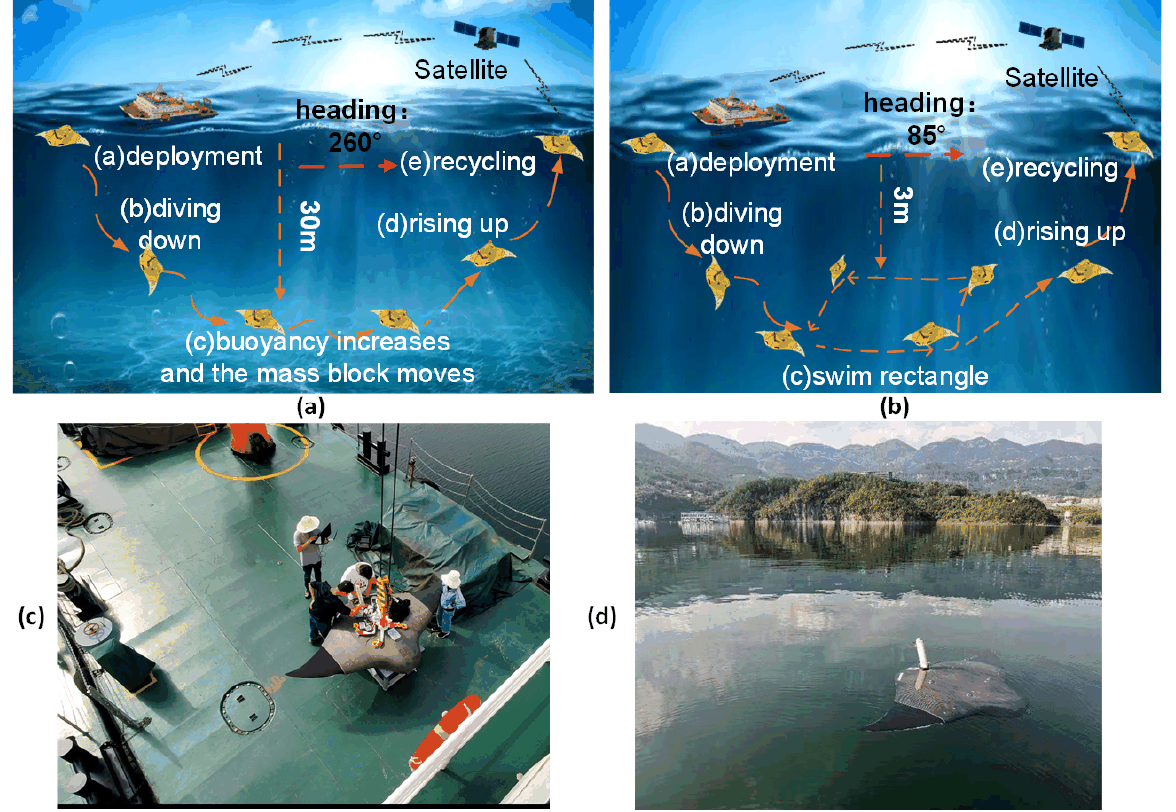
Figure 6. The gliding and flapping experiments’ setup and the experiment procedure display. ( a ) The gliding experiment’s procedure and setup; ( b ) the flapping experiment’s procedure and setup; ( c ) the prototype’s examination before deployment; ( d ) the gliding experiment carried out in the lake, and the prototype starting to glide down.